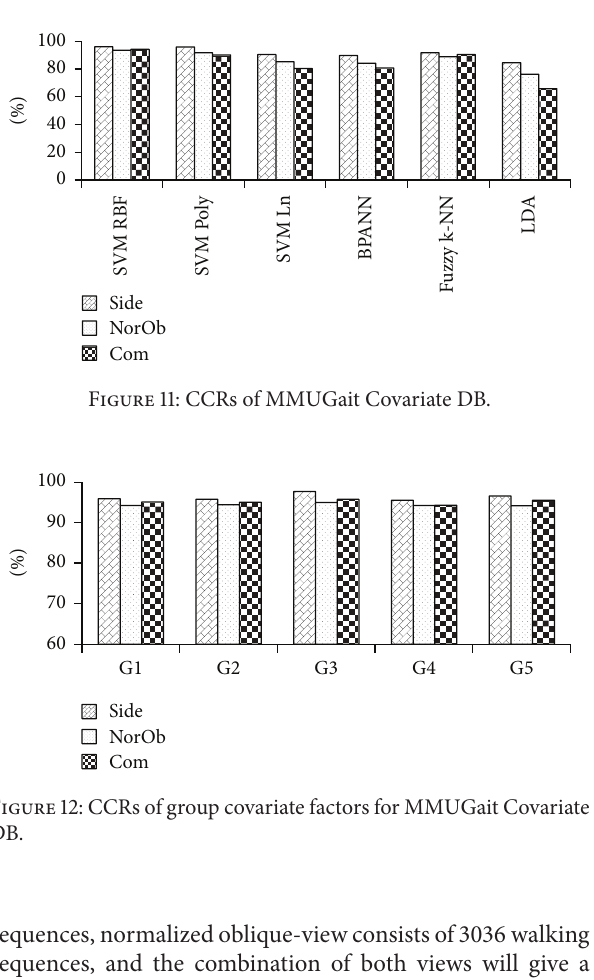
Figure 14: CCRs of SOTON Small